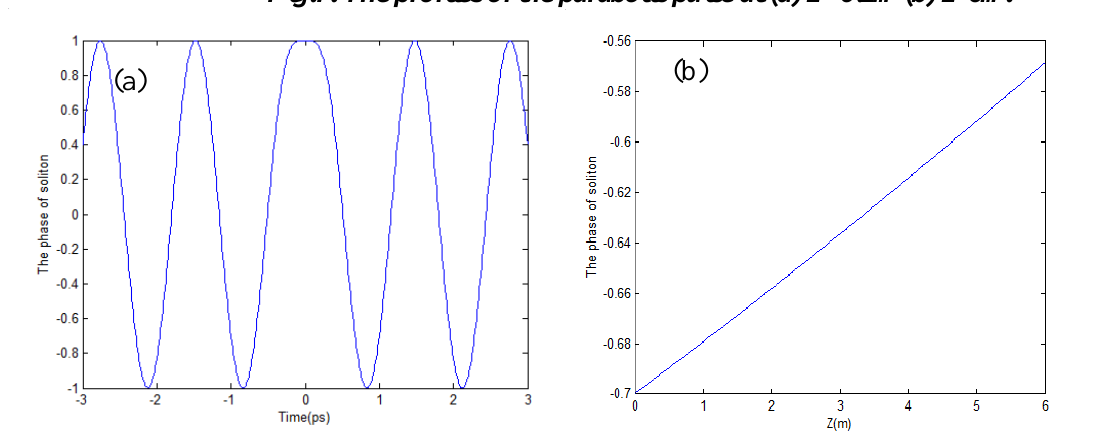
Fig. 8: The phase of soliton plotted as a function of (a) time (b)fiber